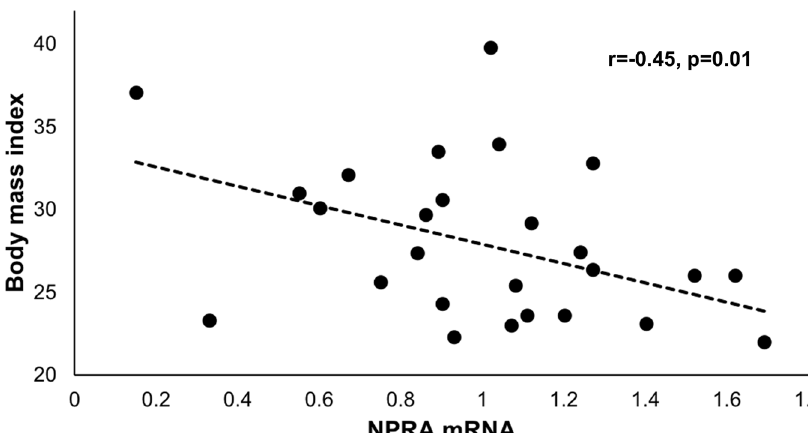
Figure 2. Association of NPRA mRNA with body mass index.